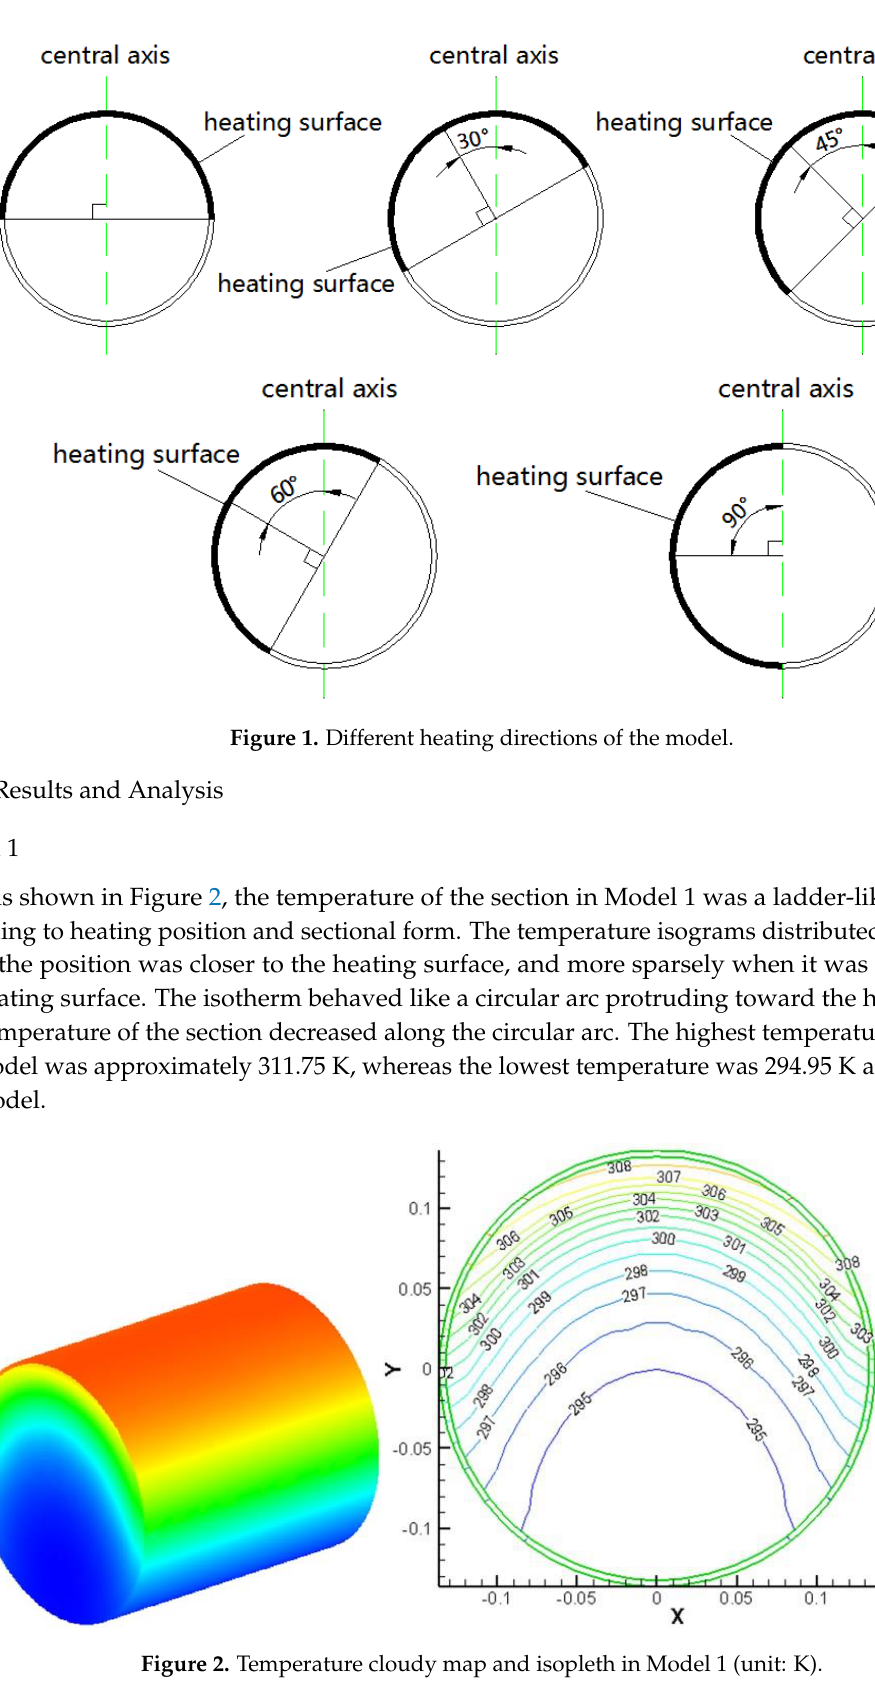
Figure 2. Temperature cloudy map and isopleth in Model 1 (unit: K).